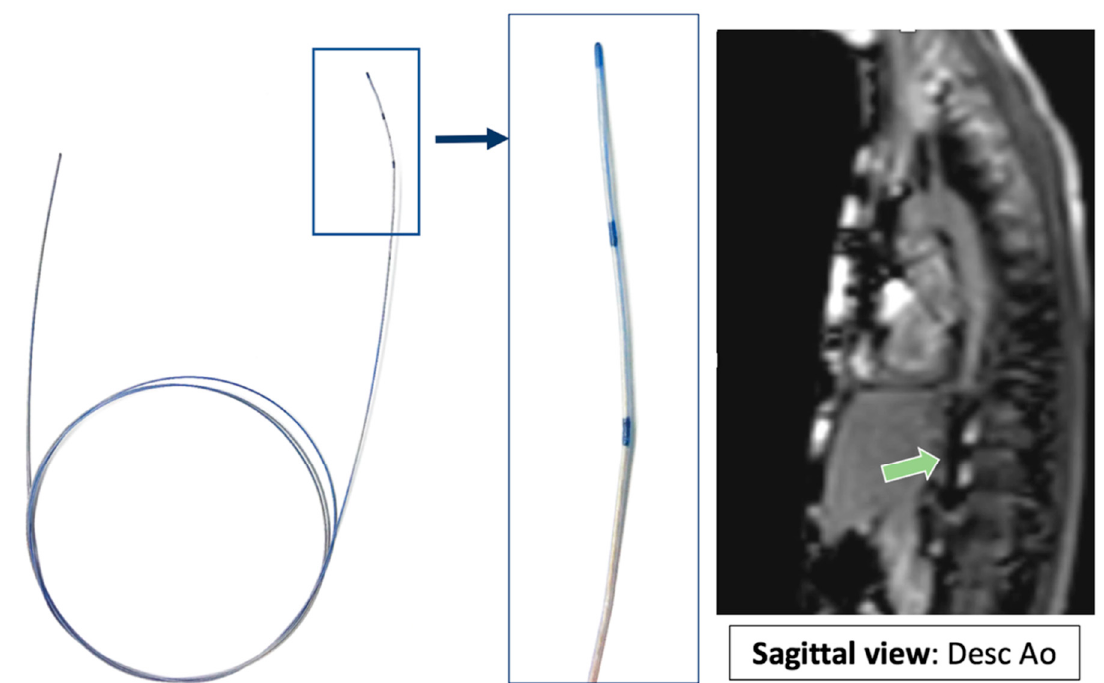
Figure 22. MR guided retrograde left heart catheterization (LHC) with an MR conditional guidewire (EmeryGlide guidewire, Nano4Imaging, Dusseldorf, Germany). Green arrow points to the guidewire artifact produced by the three markers on the tip of the wire. Revised from ref [16].